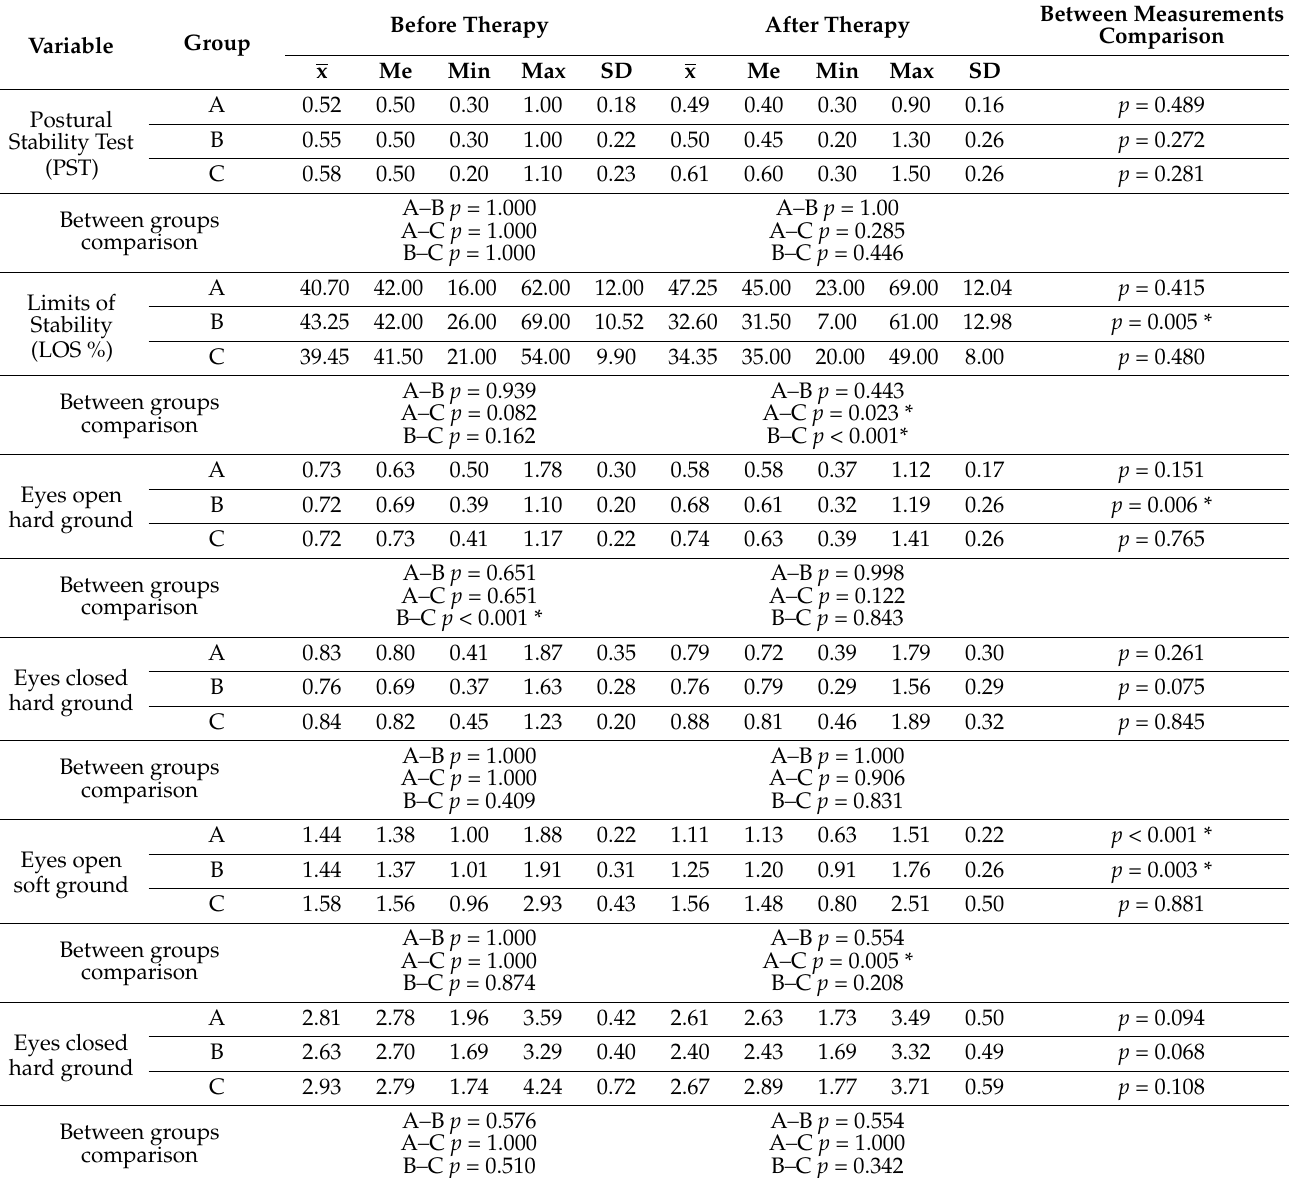
Table 6. Comparison of the balance test results in the studied groups before and after